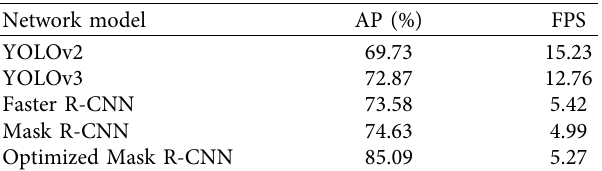
Table 4: Comparison of the optimized algorithm and several mainstream algorithms’ experimental